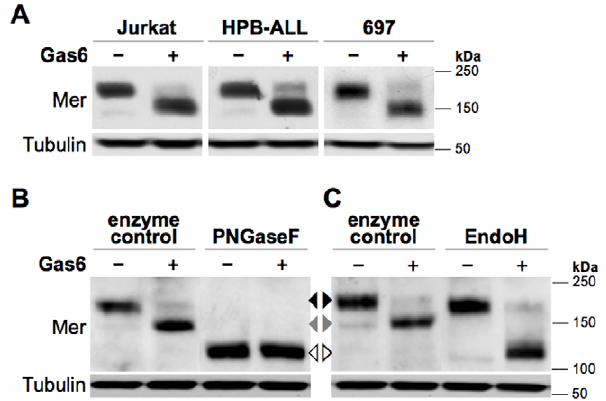
Figure 1. Long-term exposure to Gas6 induces expression of a partially N -glycosylated form of Mer. Whole-cell lysates were collected from human leukemia cell lines cultured in the presence of 200 nM Gas6 ( + ) or vehicle control ( 2 ) for 18 hours and Mer expression was determined by western blot. Blots were also probed with an anti- Tubulin antibody to confirm similar loading. ( A ) In human ALL cell lines, Gas6-treated cells express a major form of Mer with a faster electrophoretic mobility ( , 150 kDa) than Mer in control-treated cells ( , 180 kDa). ( B ) Jurkat cell lysates were digested with PNGaseF or incubated under the same conditions without PNGaseF (enzyme control) prior to SDS-PAGE. ( C ) Jurkat cell lysates were digested with EndoH or enzyme control prior to SDS-PAGE. The non-glycosylated ( % ), partially glycosylated ( % ), and fully glycosylated ( % ) Mer glycoforms are indicated between panels B and